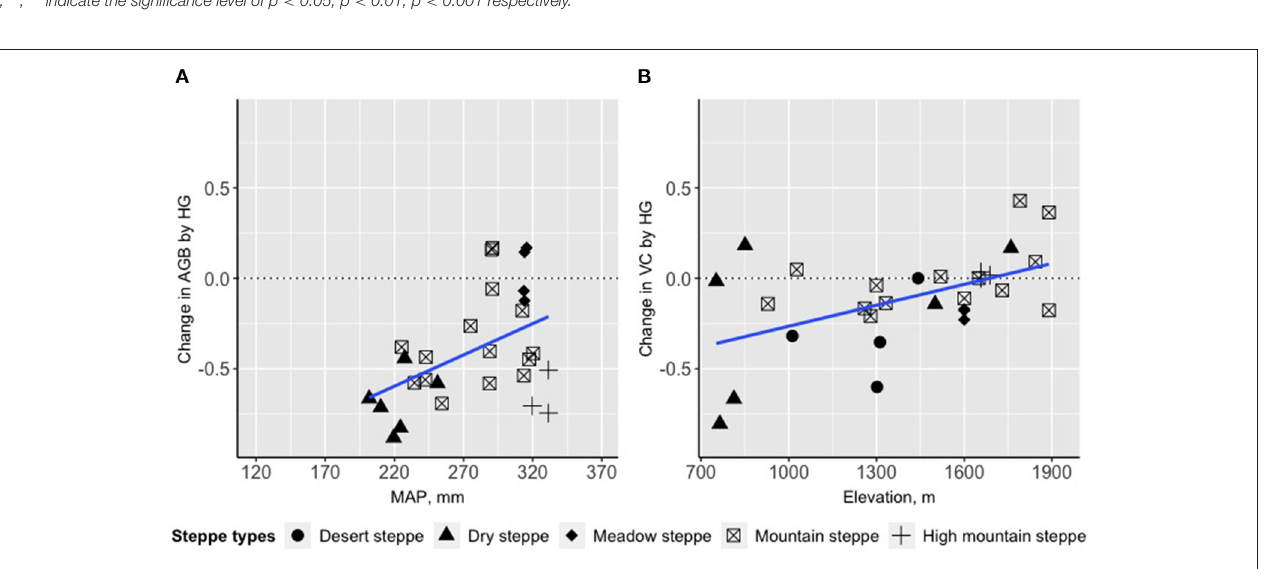
FIGURE 4 | Change of the relative grazing effects (HG: heavy vs. light grazing) on vegetation indicators along major environmental gradients. (A) change of GE on AGB ( N = 28; no data on desert steppe) along the MAP gradient, (B) change of GE on VC ( N = 30) along the elevation gradient. Environmental factors are selected based on the results from Table 3